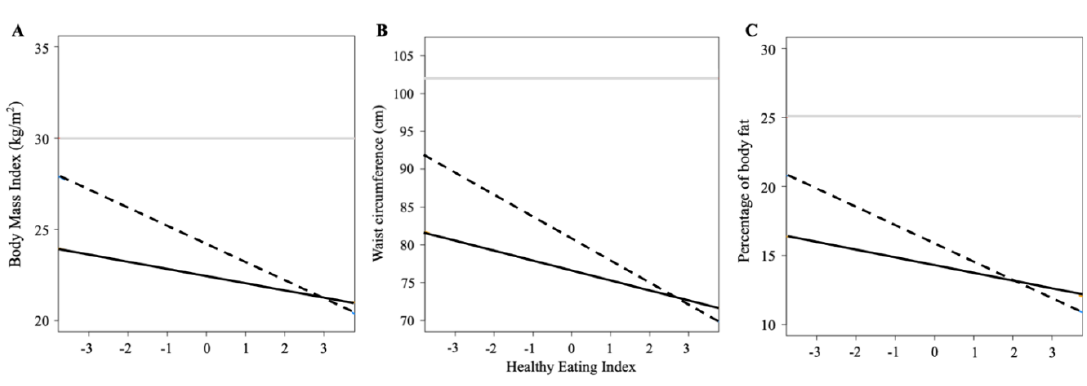
Figure 1. Estimated waist circumference and BMI for dietary quality score in male participants. Interaction plots showing the association between standardized Healthy Eating Index 2010 and ( A ) body mass index, ( B ) waist circumference, and ( C ) percentage of body fat among males in the first quintile (solid black line) and last quintile (dashed black line) of polygenic risk score of obesity. The solid grey line represents the cut-off value for obesity ( A ) or increased obesity-related health risk ( B ) according to body mass index or waist circumference or percentage of body fat.